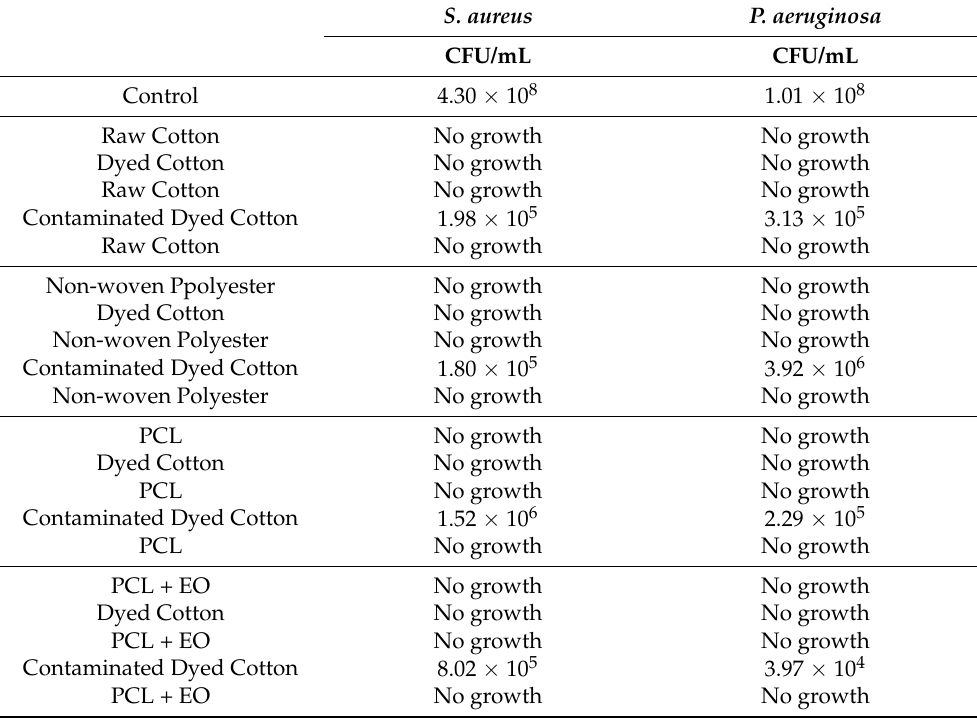
Table 5. Contamination test